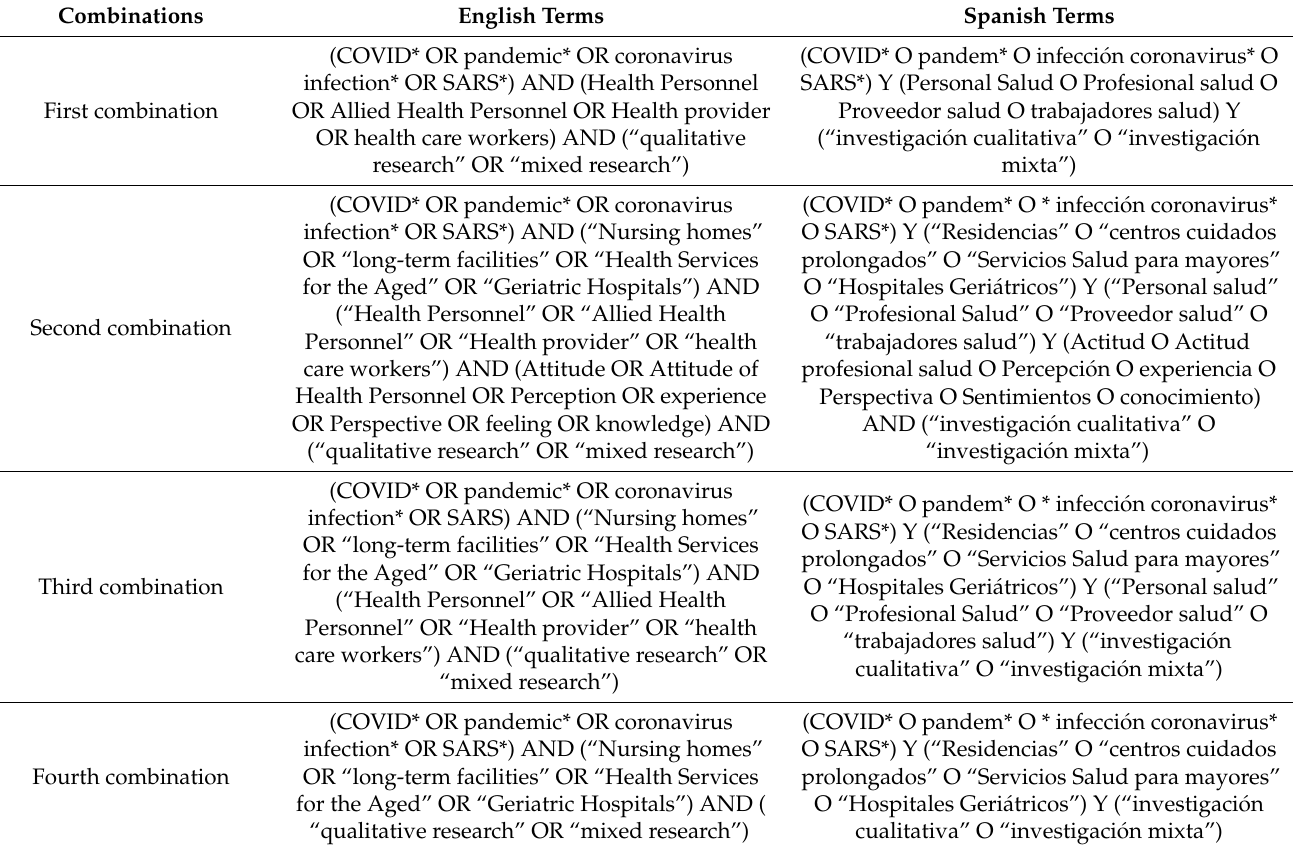
Table 1. Search terms and their